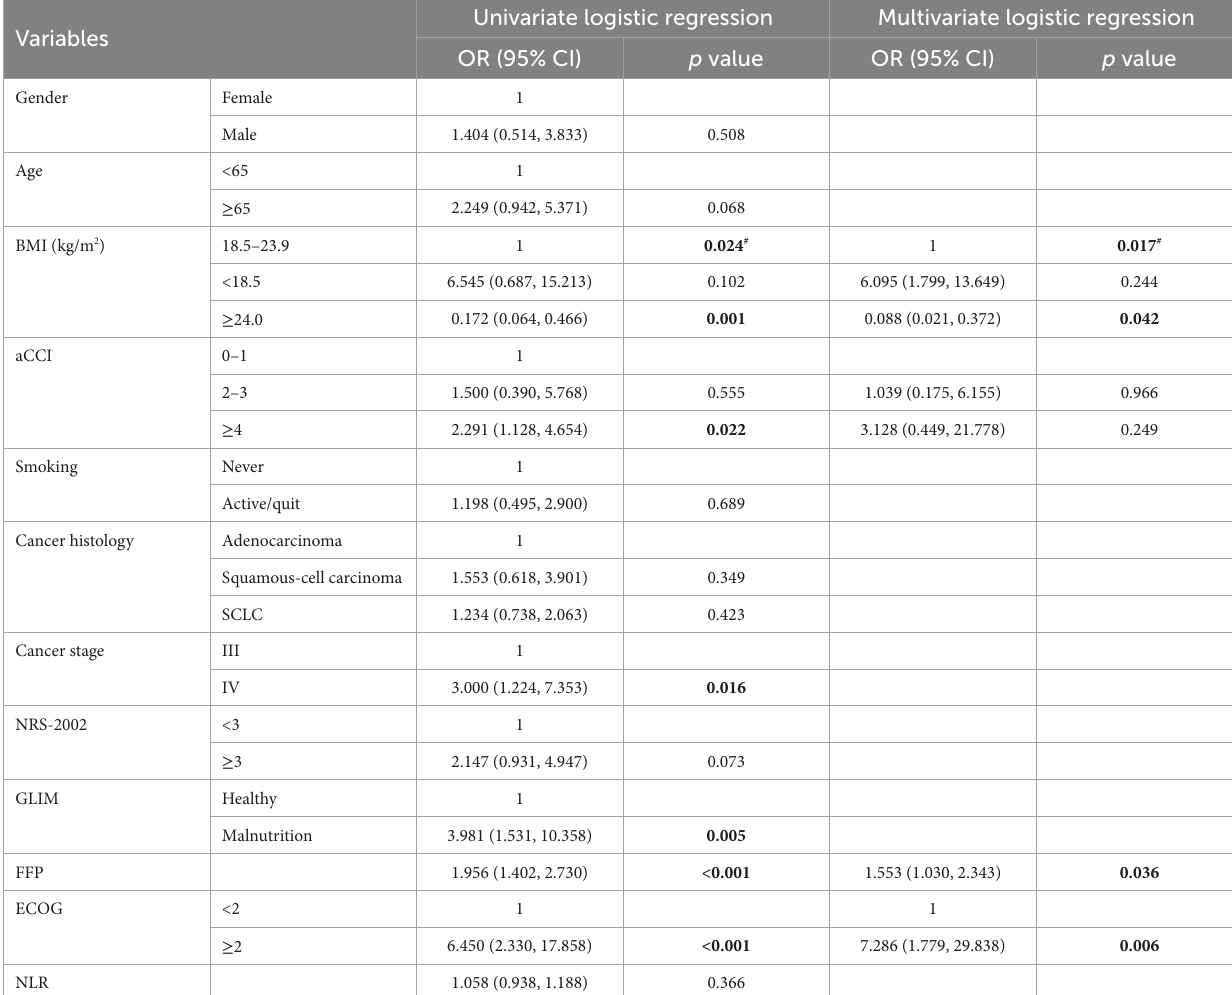
TABLE 4 Univariate and multivariate logistic regression